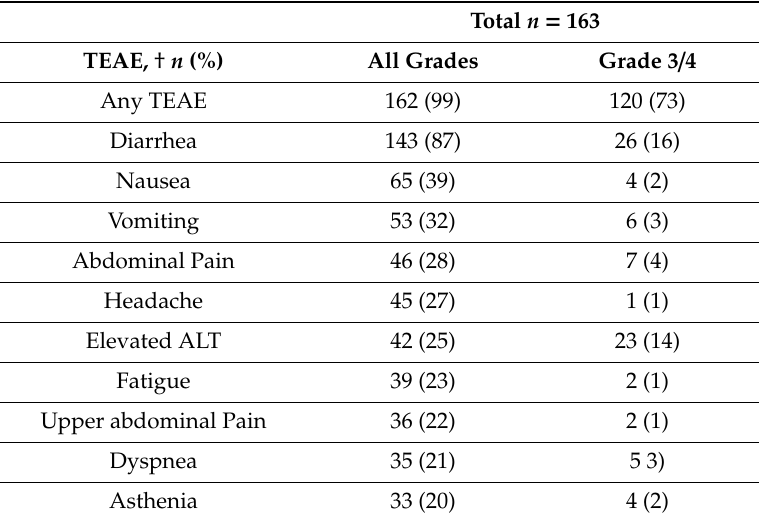
Table 1. Summary of adverse events in the BYOND